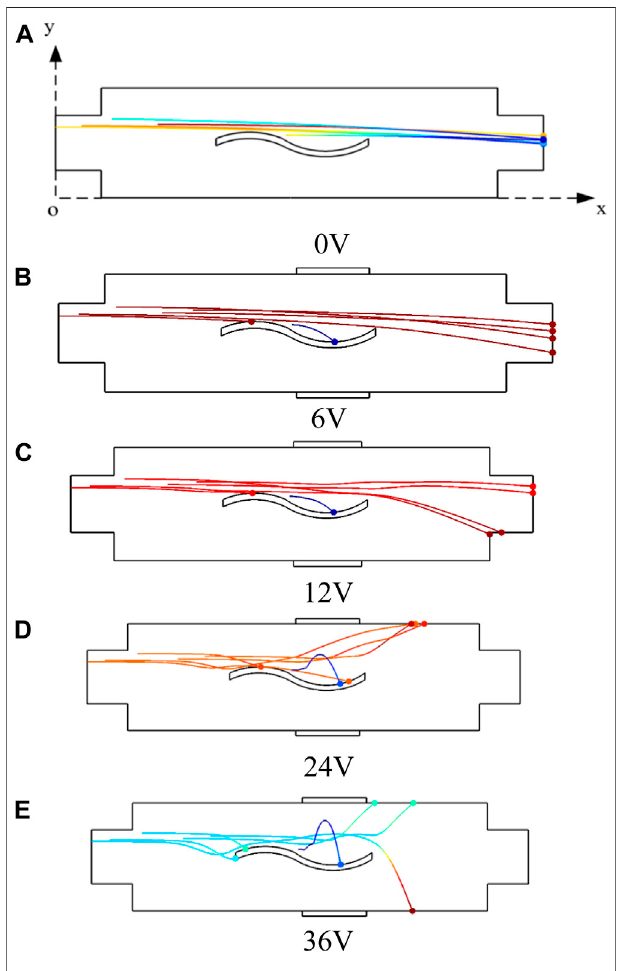
FIGURE9| Trajectories ofliquid metal particlesunder different voltages. (A) 0 V, (B) 6 V, (C) 12 V, (D) 24 V, (E) 36 V.